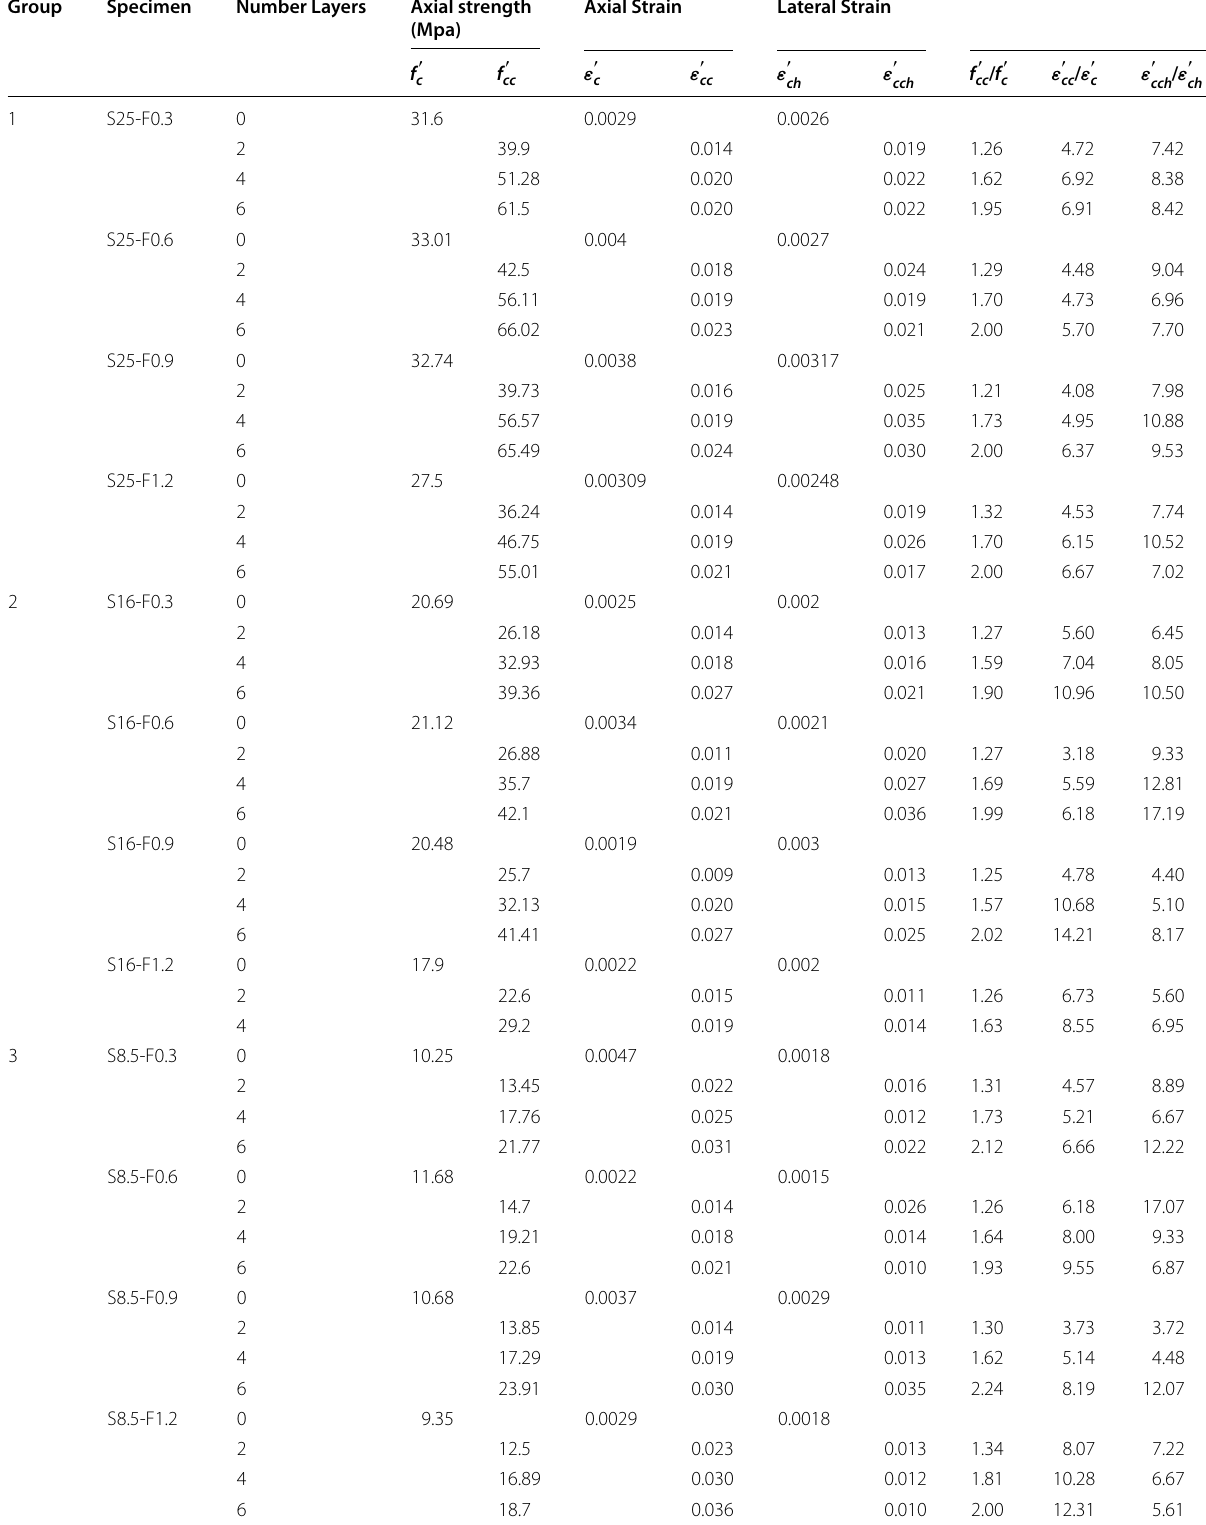
Table 5 Summary of test